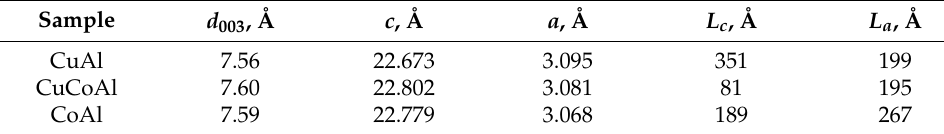
Table 1. Microstructural parameters of the CuAl-, CoAl- and CuCoAl-LDHs.